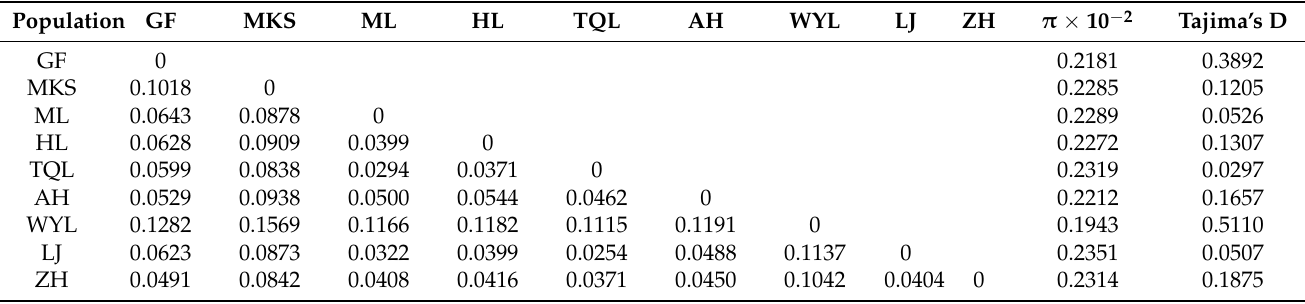
Table 1. F st between 9 populations, π and Tajima. D neutral test in P. koraiensis